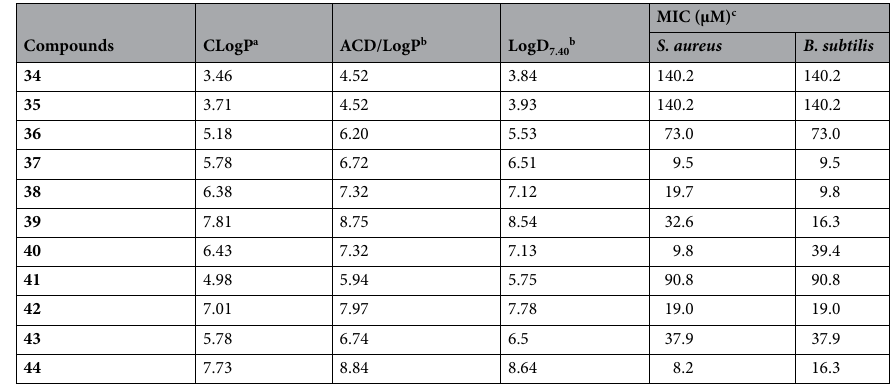
Table 4. Physico-chemical parameters and antimicrobial activities of compounds 34 to 44 13 . a The CLogP values were calculated using software ChemBioDraw Ultra 12.0. b The ACD/Log P and LogD 7.40 values were calculated using software ACD/Labs 6.0. c MIC, minimum inhibitory concentration; S. aureus , Staphylococcus